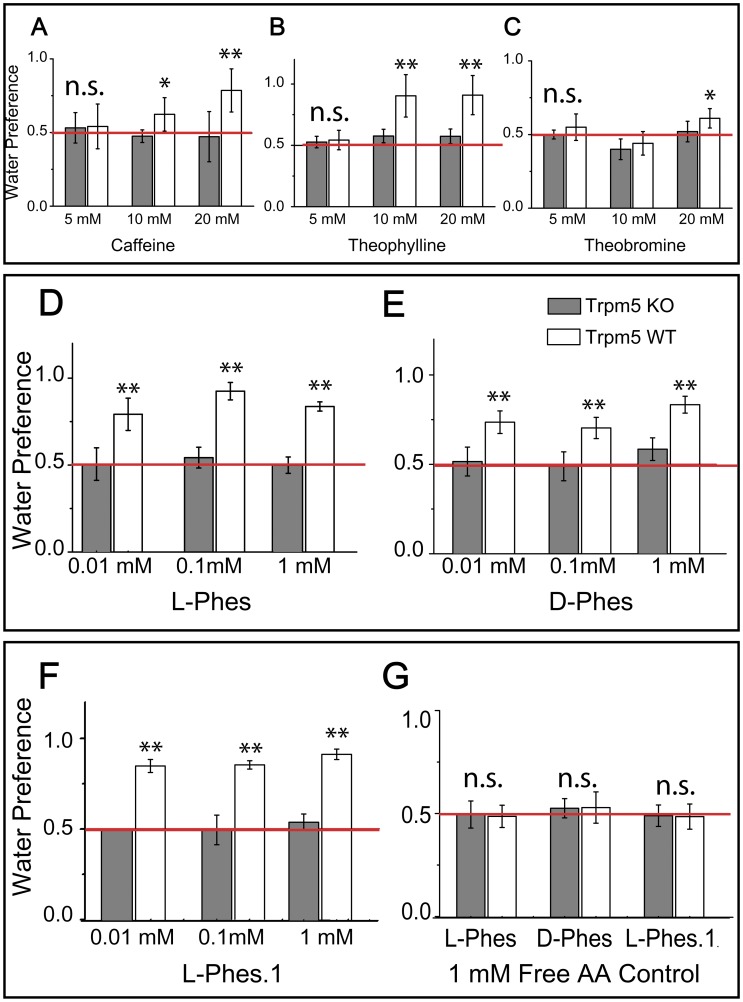
Trpm5 dependent bitter substances.Short-term (10 min) (A) caffeine vs. water, (B) theophylline and (C) theobromine two-bottle preference tests. Trpm5 knockout (“KO”) mice displayed indifference to all choices. (D) The bitterness of Phenylseptin peptides is dependent on Trpm5 regulation. Short-term (10 min) (E) L-Phes vs. water, (F) D-Phes vs. water and (3) L-Phes.1 vs. water two-bottle preference tests. Trpm5 knockout (“KO”) mice displayed indifference to all choices. Values displayed as preference ratios for water. (G) Amino acid organization on peptide structure is fundamental to gustatory perception. Short-term (10 min) L-Phes mixture vs. water and D-Phes mixture vs. water. Wild-type and Trpm5 knockout (“KO”) mice were equally indifferent to all choices. Values displayed as preference ratios for water. Post-hoc (Bonferroni-corrected) one sample t-test against indifference ratio of 0.5: *p<0.05; **p<0.04; all other comparisons p>0.05. Red line denotes level of indifference (preference ratio of 0.5).